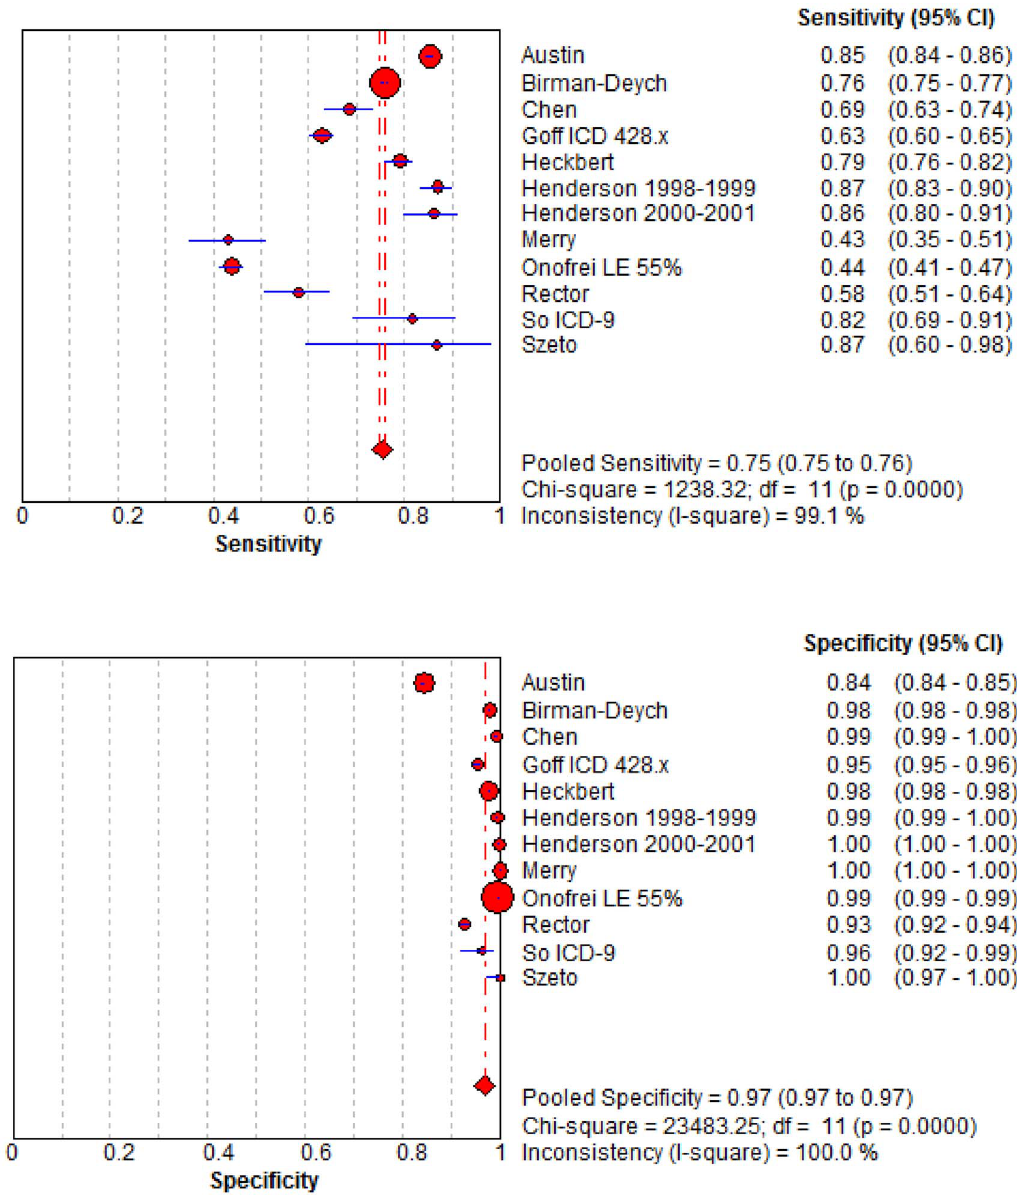
Figure 2. Forest Plots of Sensitivities and Specificities of Heart Failure Codes as Reported by Included Studies. 95% CI=95% confidence interval; DF=degrees of